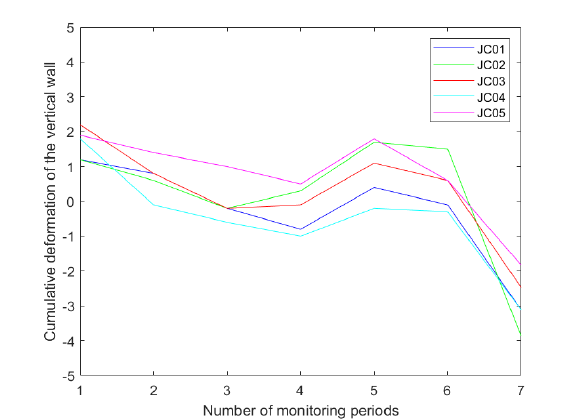
Figure 6 . Schematic diagram of bulging cumulative deformation